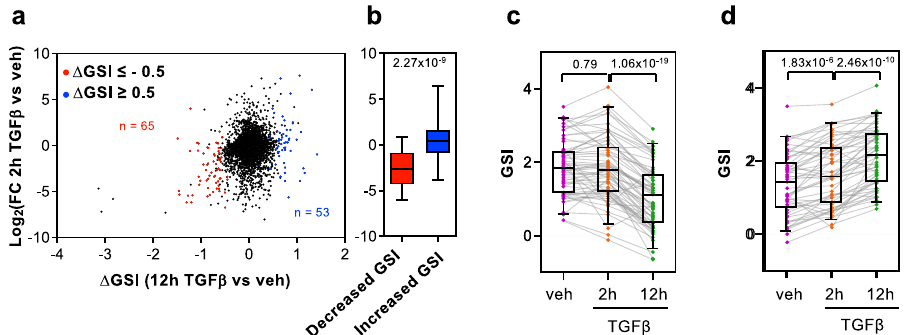
Fig. 5 Effect of 12 h of TGF β treatment on GSI changes ( Δ GSI). a Scatter plot of nascent pre-mRNA level changes (log 2 FC) versus GSI changes ( Δ GSI) after 12 h of TGF β . Genes with decreased GSI ( Δ GSI < – 0.5, p < 0.05) or increased GSI ( Δ GSI > 0.5, p < 0.05) are depicted in red or blue, respectively. b Boxplot of nascent pre-mRNA level changes (log 2 FC) after 12 h of treatment with TGF β versus vehicle in genes with decreased GSI or increased GSI. Unpaired Student ’ s t -test p -values are shown. c , d GSI levels at the three conditions tested (vehicle or 2 and 12 h of TGF β -treated at the 2 h or 12 h time point) for genes with a decreased GSI ( c ) or an increased GSI ( d ) after 12 h of TGF β . Paired Student ’ s t -test p -values of the comparison between the indicated distributions are shown. Sample size ( n ) of all set of data are provided in Supplementary Data